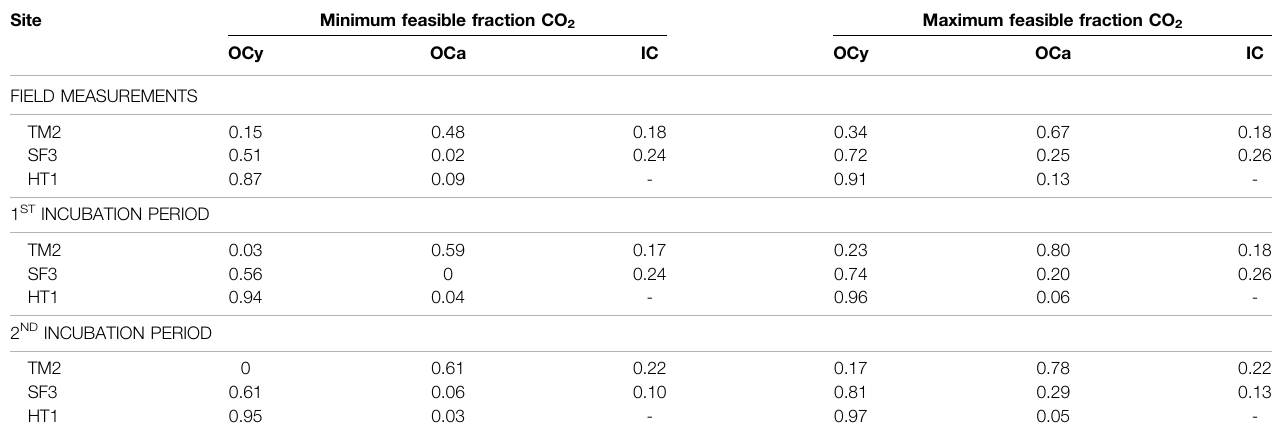
TABLE 3 | Distributions of C pools contributing to the CO 2 released in the fi eld and in the incubations.